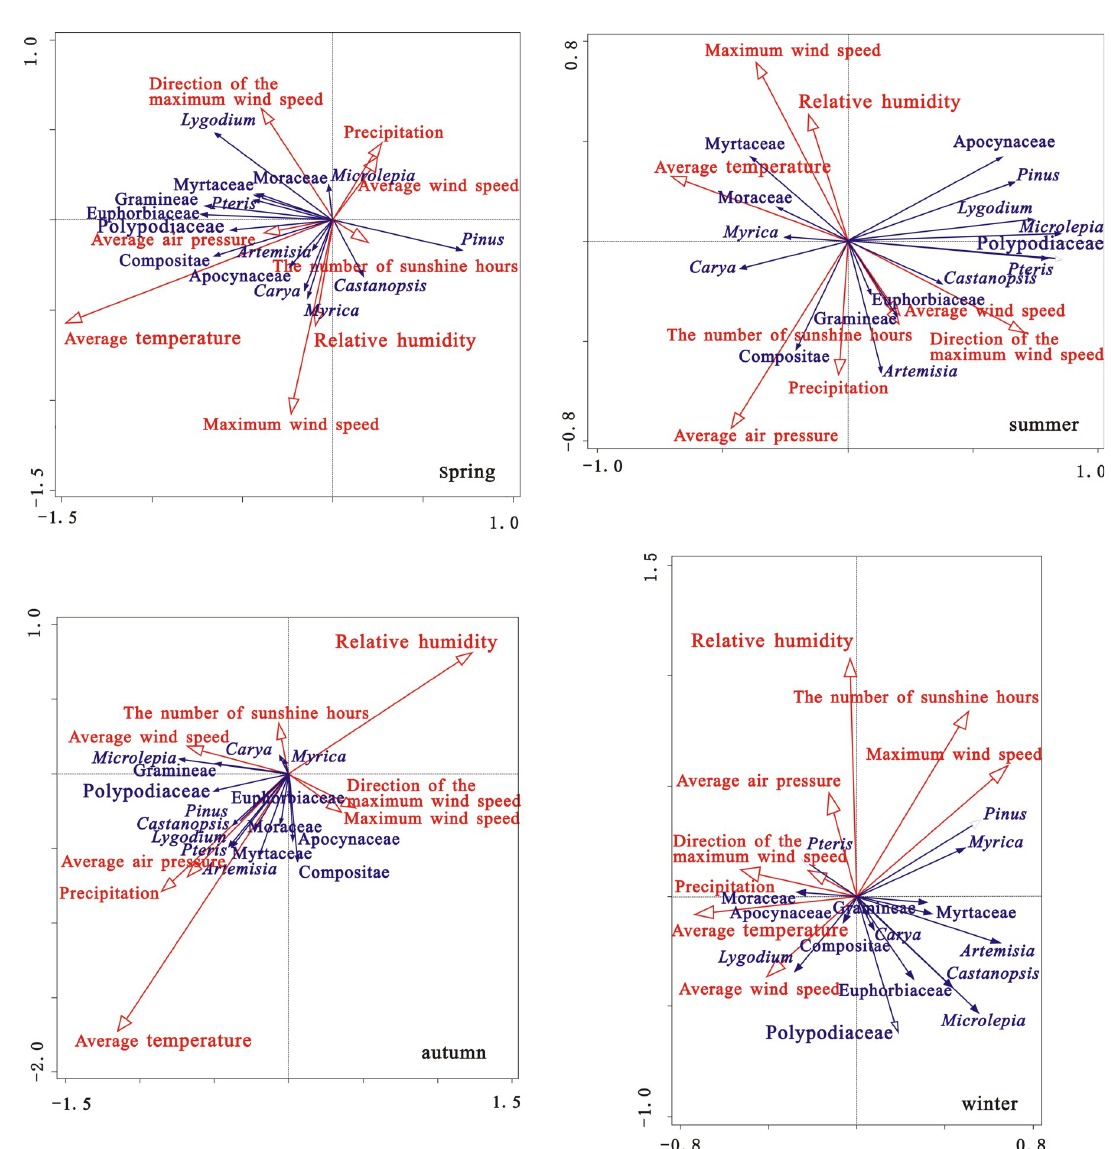
Fig 5. Results of RDA of the concentrations of major pollen types and meteorological parameters in different seasons in central Zhanjiang city during 2015-~2016.